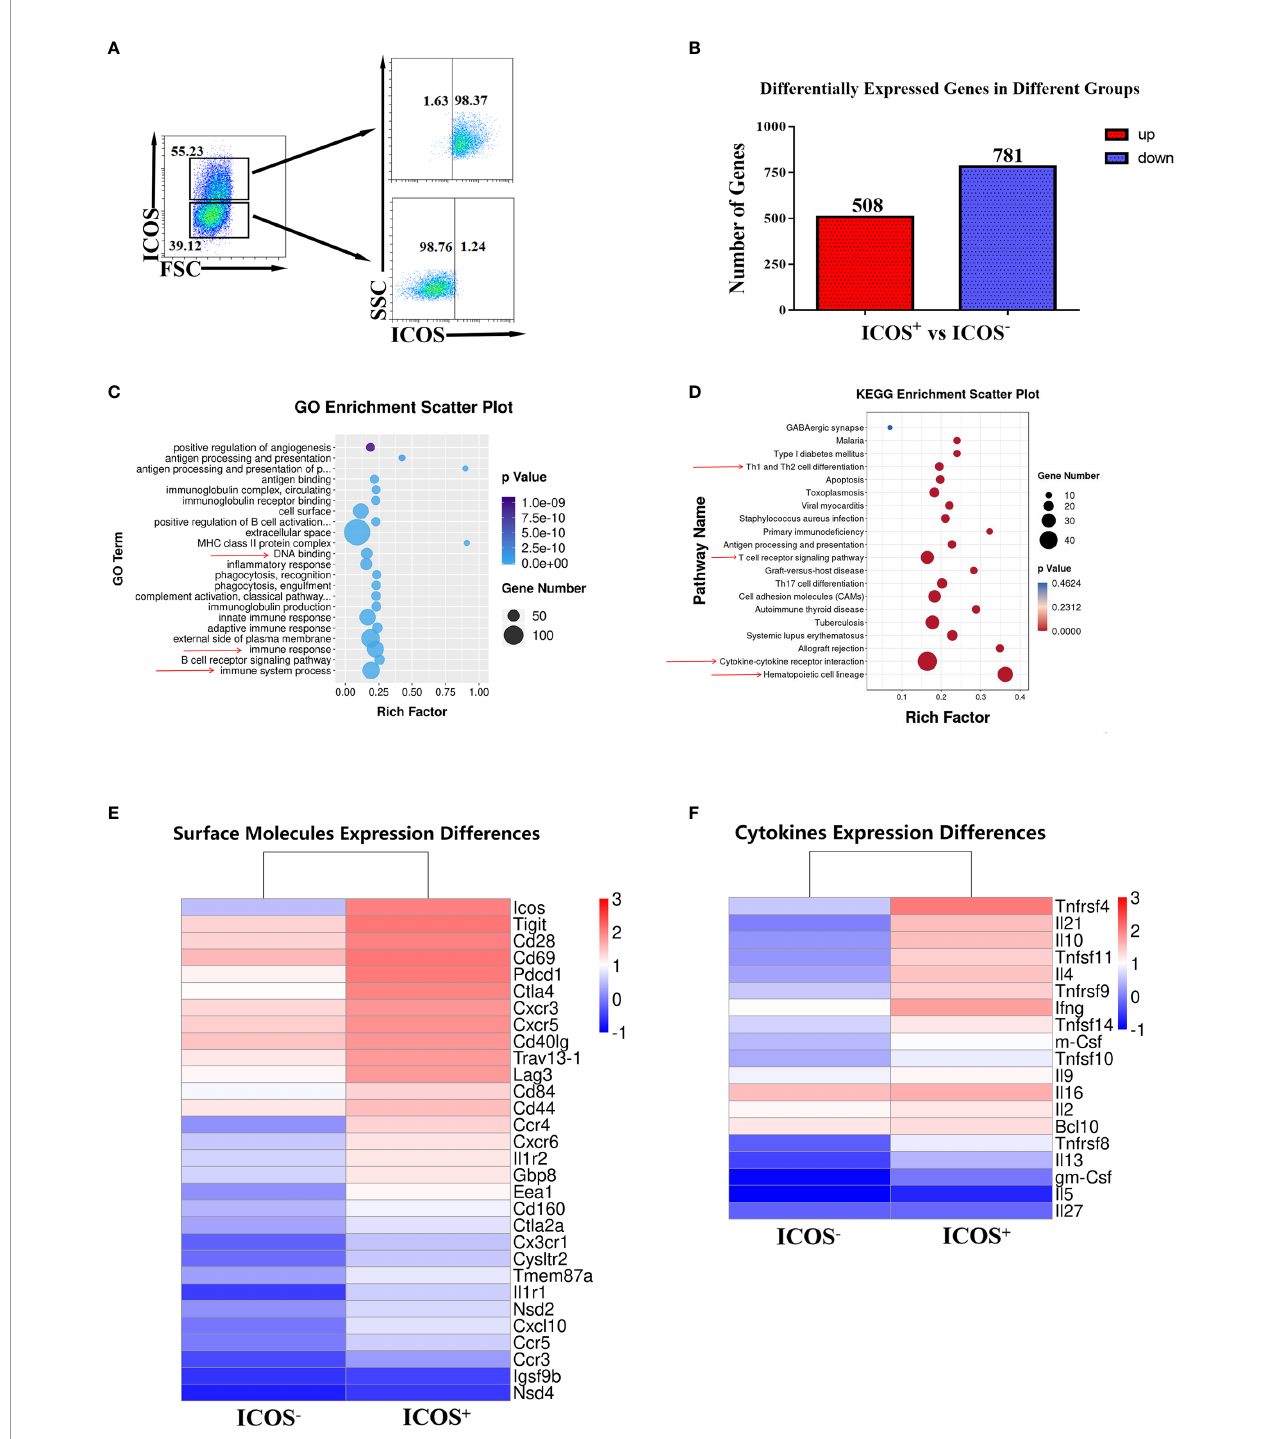
FIGURE 3 | Different RNA expression between ICOS + and ICOS − splenic Th cells. Five to 6 weeks after S. japonicum infection, splenocytes were isolated and stained by different fl uorescence-labeled antibodies. (A) CD3 + CD4 + ICOS + T cells and CD3 + CD4 + ICOS − T cells were sorted by FACS, and the puri fi cation was identi fi ed by FACS. RNA was extracted from these two puri fi ed cell populations, respectively. RNA sequencing was done. (B) Differentially expressed genes in CD4 + ICOS − /+ Th cells were shown. (C) GO enrichment analysis of differentially expressed genes in ICOS − /+ Th cells was shown. (D) KEGG enrichment scatter plots of differentially expressed genes in ICOS − /+ Th cells were shown. (E) Differences of surface molecule expression in ICOS − /+ Th cells were shown. (F) Differences of cytokine expression in ICOS − /+ Th cells were